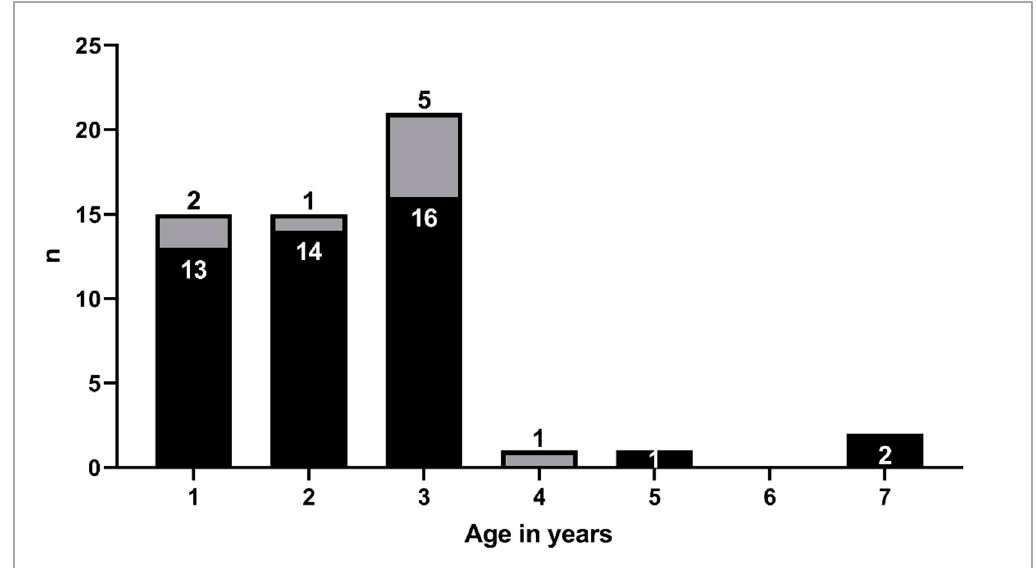
Figure 1. Age distribution and Mycobacterium avium subspecies paratuberculosis (MAP) status of the sampled goats within the study ( n = 55). MAP-negative (black, n = 46), MAP-positive (gray, n = 9). Sampling